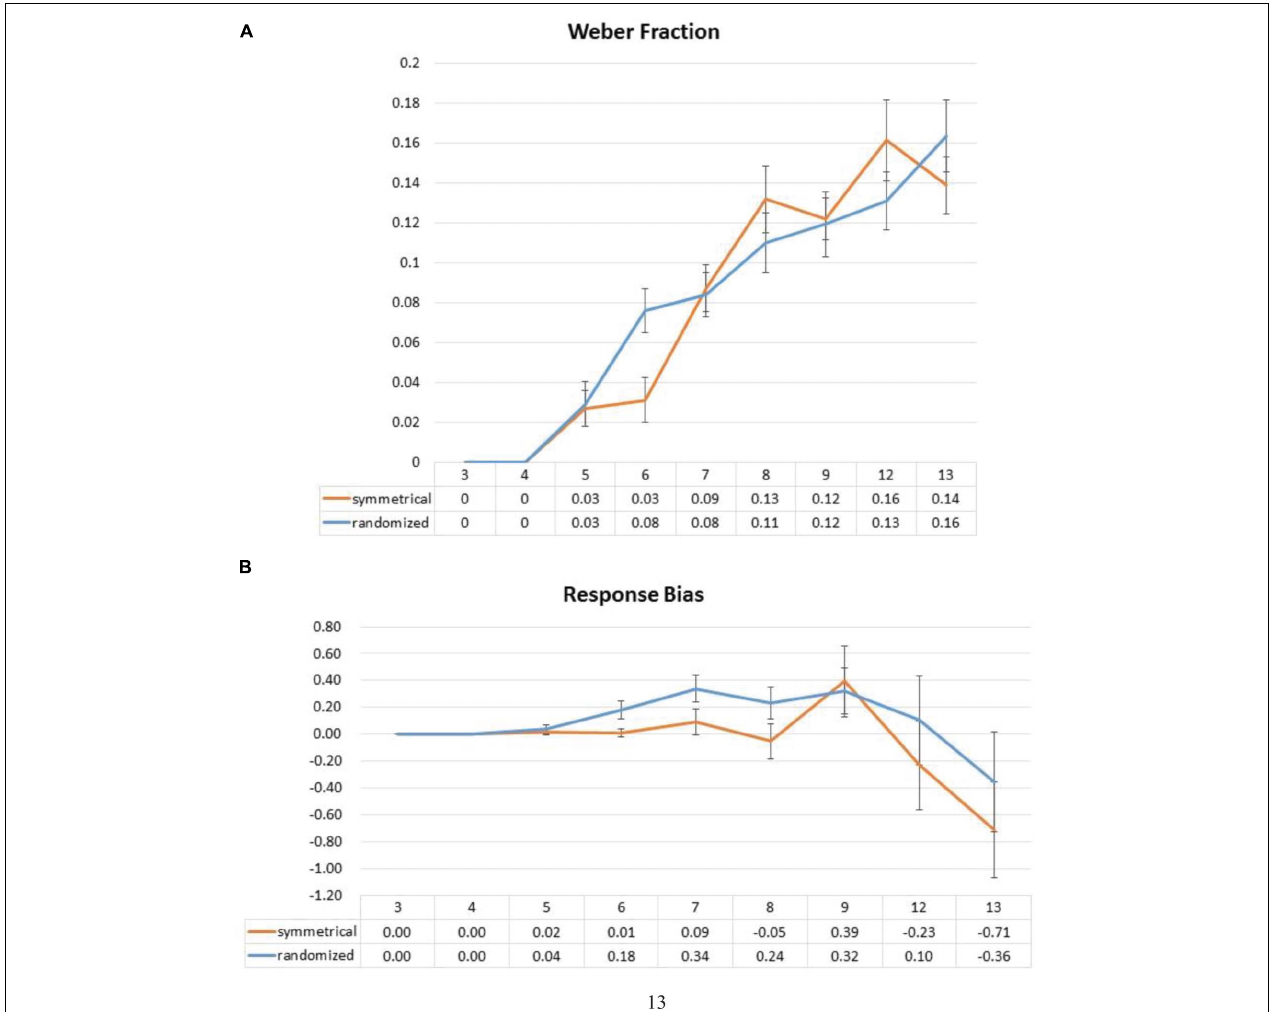
FIGURE 5 | Effect of symmetrical structure on Weber fractions (A) and response bias (B) . Weber fraction is a ratio of average error in relation to target size by dividing standard deviation of one by perceived numerosity. Response bias is computed by subtracting set size from the average response such that a positive difference would denote overestimation, and vice versa. Error bars represent standard error of the